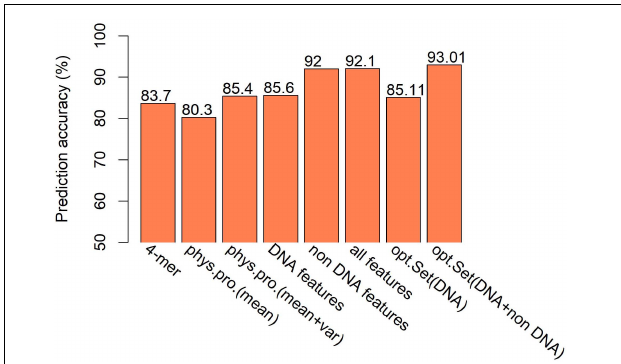
FIGURE 7 | Comparison of SVM-based prediction accuracy between various feature sets. Feature range used in the prediction is 300 bp. Results are based on combined decision values inferred from five-fold cross validation. “phys.pro.” denotes physical property-based prediction, and “opt.Set” denotes optimal feature set.